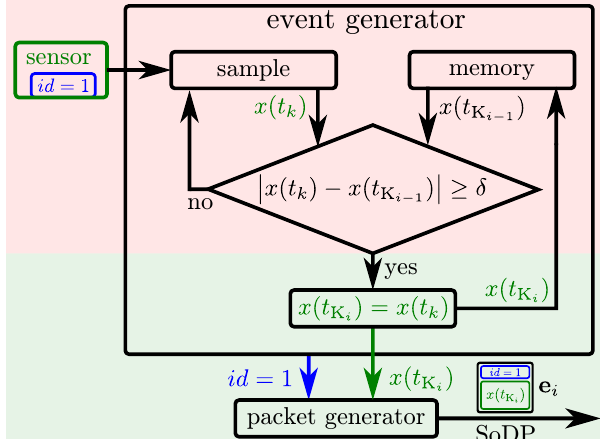
Figure 2. A networked module/skin cell with local processing capabilities, see Figure 1, can realize an event generator (EG) and an event packet generator (EPG) representing events in the SoDP; a sensor ) of the previous event with an ID is sampled and its value x ( t k ) is compared with the value x ( t K i − 1 e i − 1 ; if the absolute difference is below δ , then the next sample is acquired, otherwise a new event e i is ) ; the EPG creates an event packet containing the ID of the sensor generated with a sensor value x ( t K i ) ; the red background indicates components that are strictly clock-driven, and the sensor value x ( t K i and the green background represents components that are event-driven.